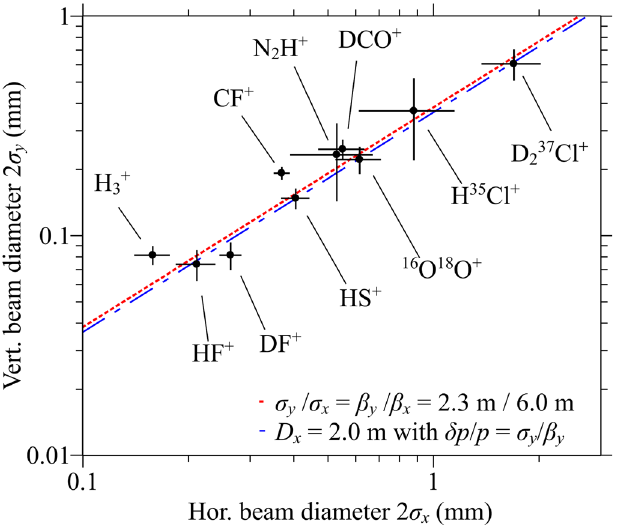
FIG. 9. Steady-state horizontal ( x ) and vertical ( y ) beam diameters 2 σ as a function of ion mass. The shaded green area shows the span of expected horizontal beam diameters in equilibrium between electron cooling and IBS heating [Eq. (16)], given the observed τ . The upper and lower limits cool correspond to 10 6 and 10 4 stored ions,